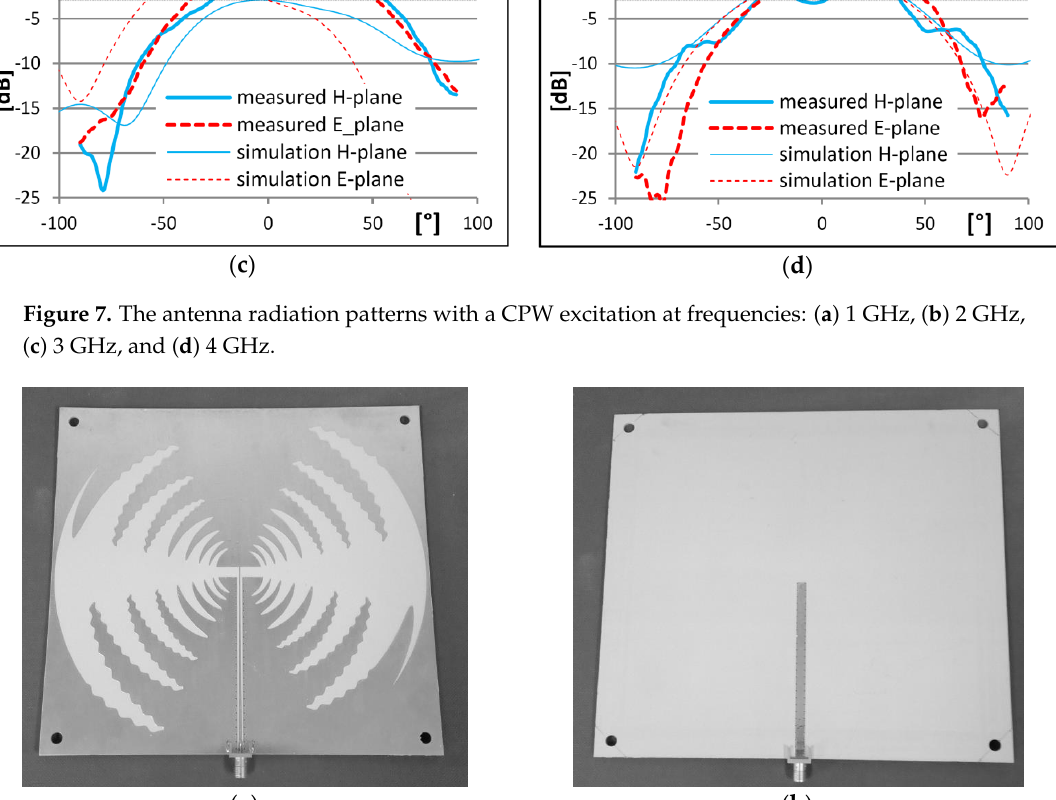
Table 2. The resulting parameters of the manufactured antenna with coplanar waveguide with ground (CPWG) feeding.